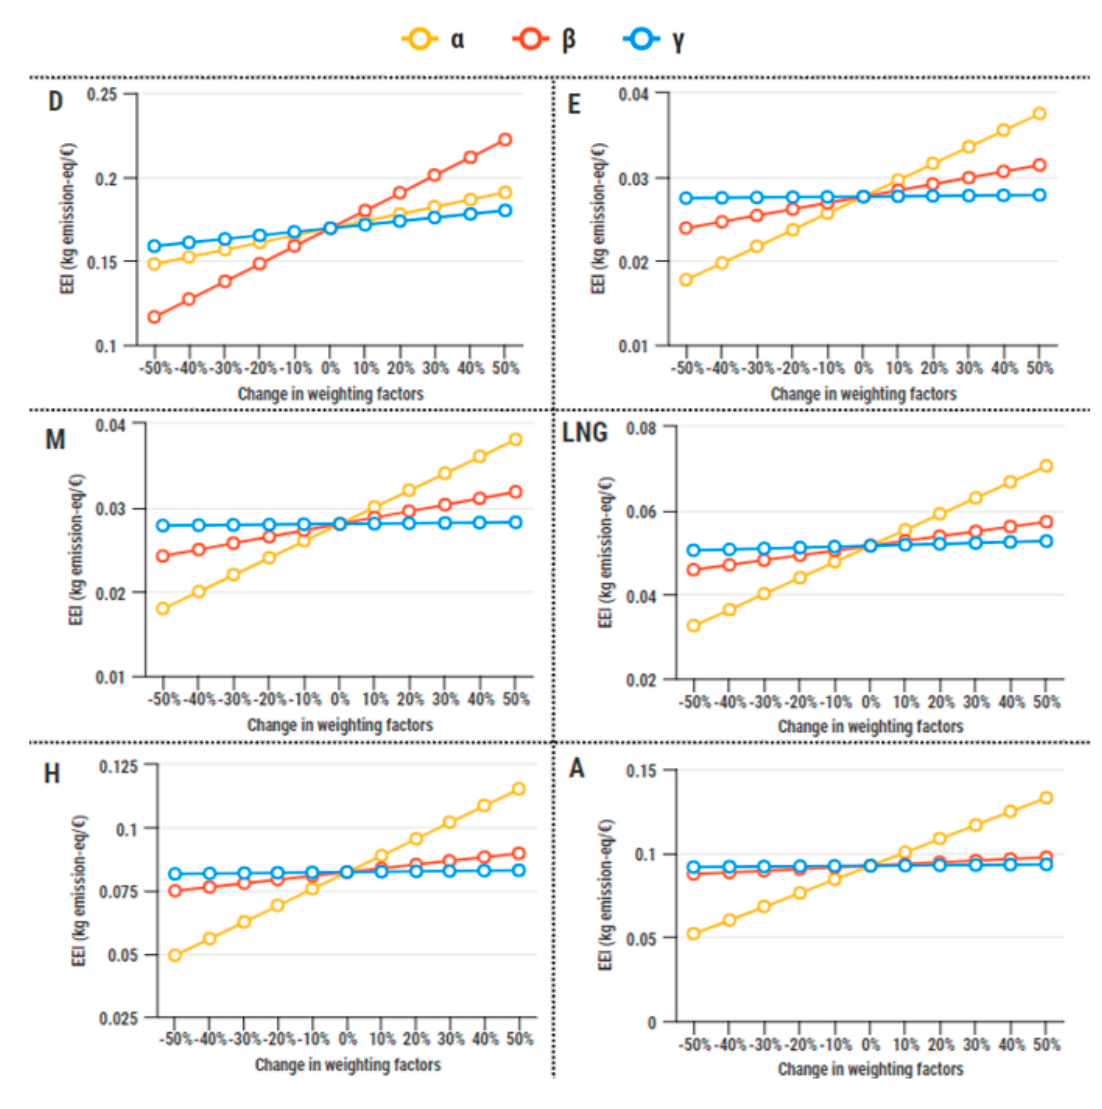
Figure 12. Impact of weighting factors on EEI.